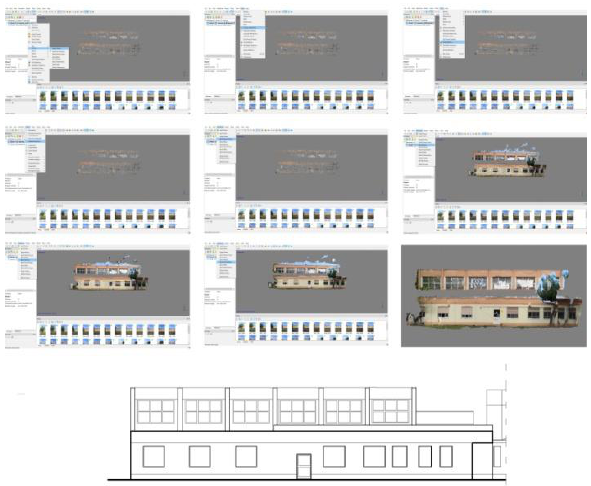
Figure 6. Digital reconstruction phases of a Borgomarino school facade, photoplane edit and CAD